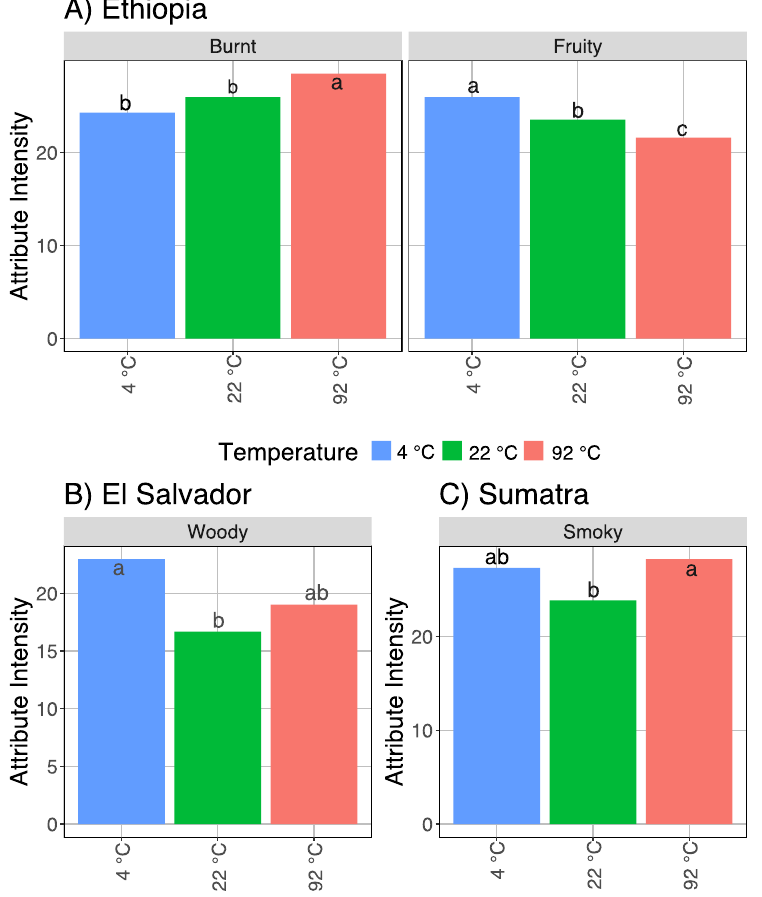
Figure 6. The attributes significantly different by brew temperature for individual origins, with LSD letter codes; ( A ) Ethiopia; ( B ) EI Salvador; ( C ) Sumatra.